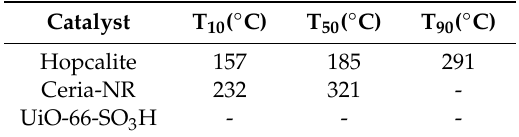
Table 2. During the light-o ff curve study, only CO 2 and H 2 O products have been observed. Table 2. Catalytic properties of the solids in the toluene